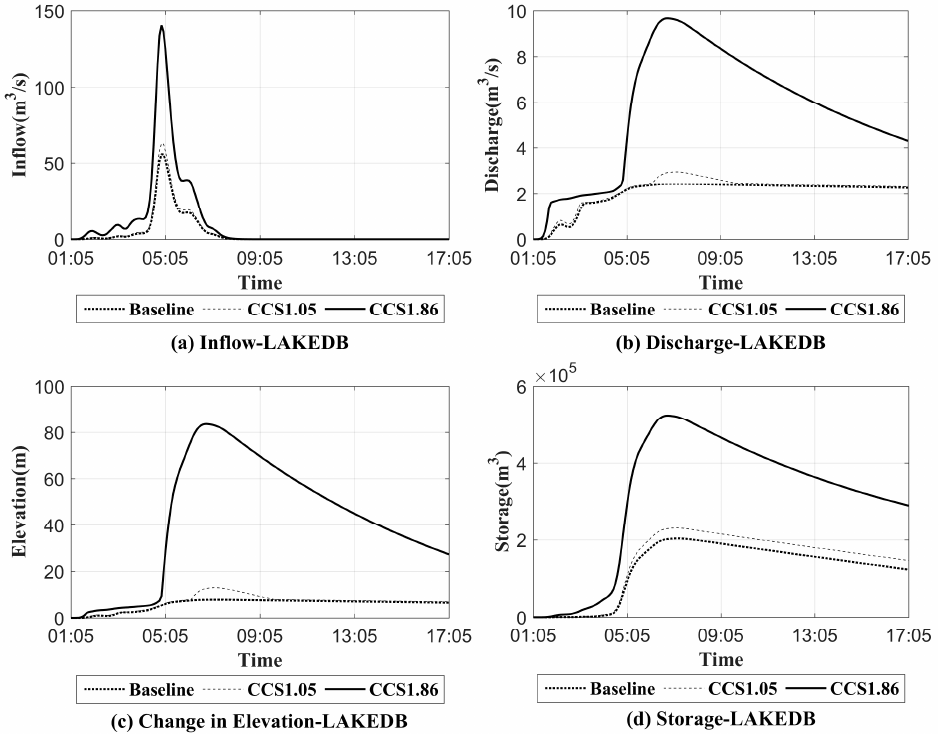
Figure 4. Time series plot of inflow, discharge, change in elevation, and storage from HEC-HMS outputs for the Lake Detention Basin (LAKEDB).